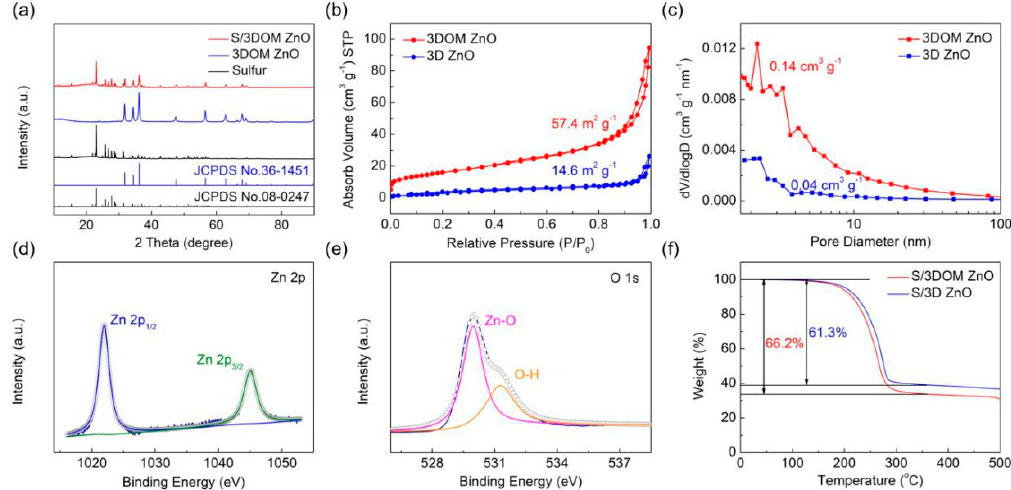
Figure 3. ( a ) XRD patterns of pure sulfur, 3DOM ZnO, and S / 3DOM ZnO; ( b ) N 2 adsorption / desorption isotherms of 3DOM ZnO and 3D ZnO; ( c ) Pore size distribution curves of 3DOM ZnO and 3D ZnO; ( d ) Zn 2p and ( e ) O 1s XPS spectrum of 3DOM ZnO; ( f ) TGA curves of S / 3DOM ZnO and S / 3D ZnO composites measured under N 2 atmosphere from room temperature to